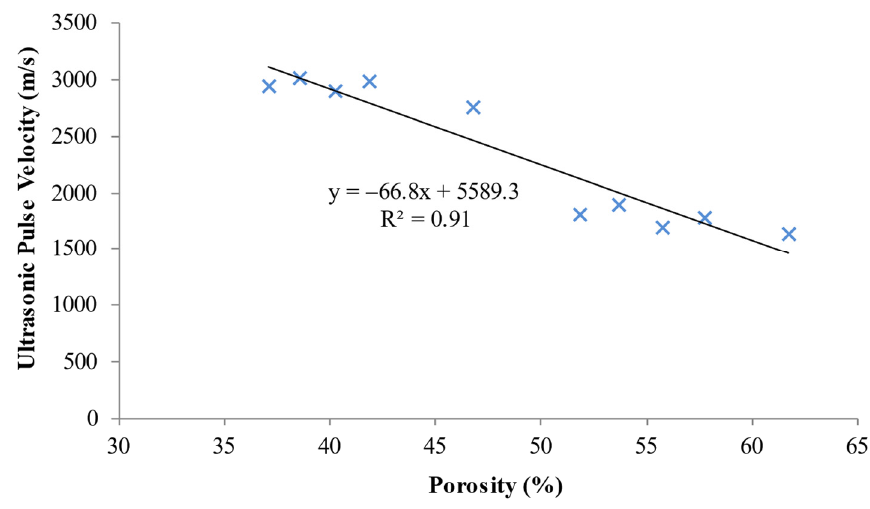
Figure 13. Correlation between the ultrasonic pulse velocity and porosity of LFC.